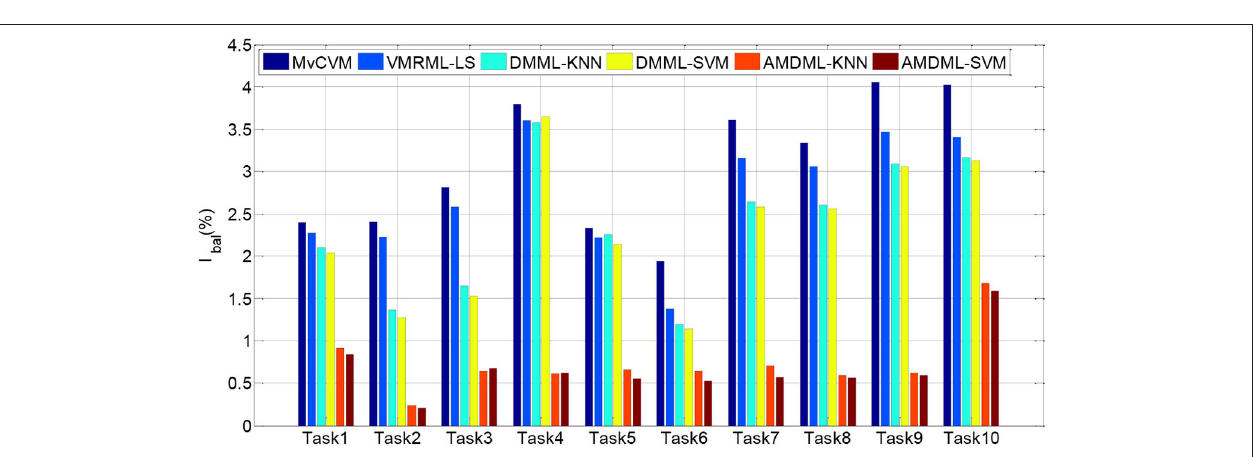
FIGURE 3 | l bal performance of six methods on all EEG classification